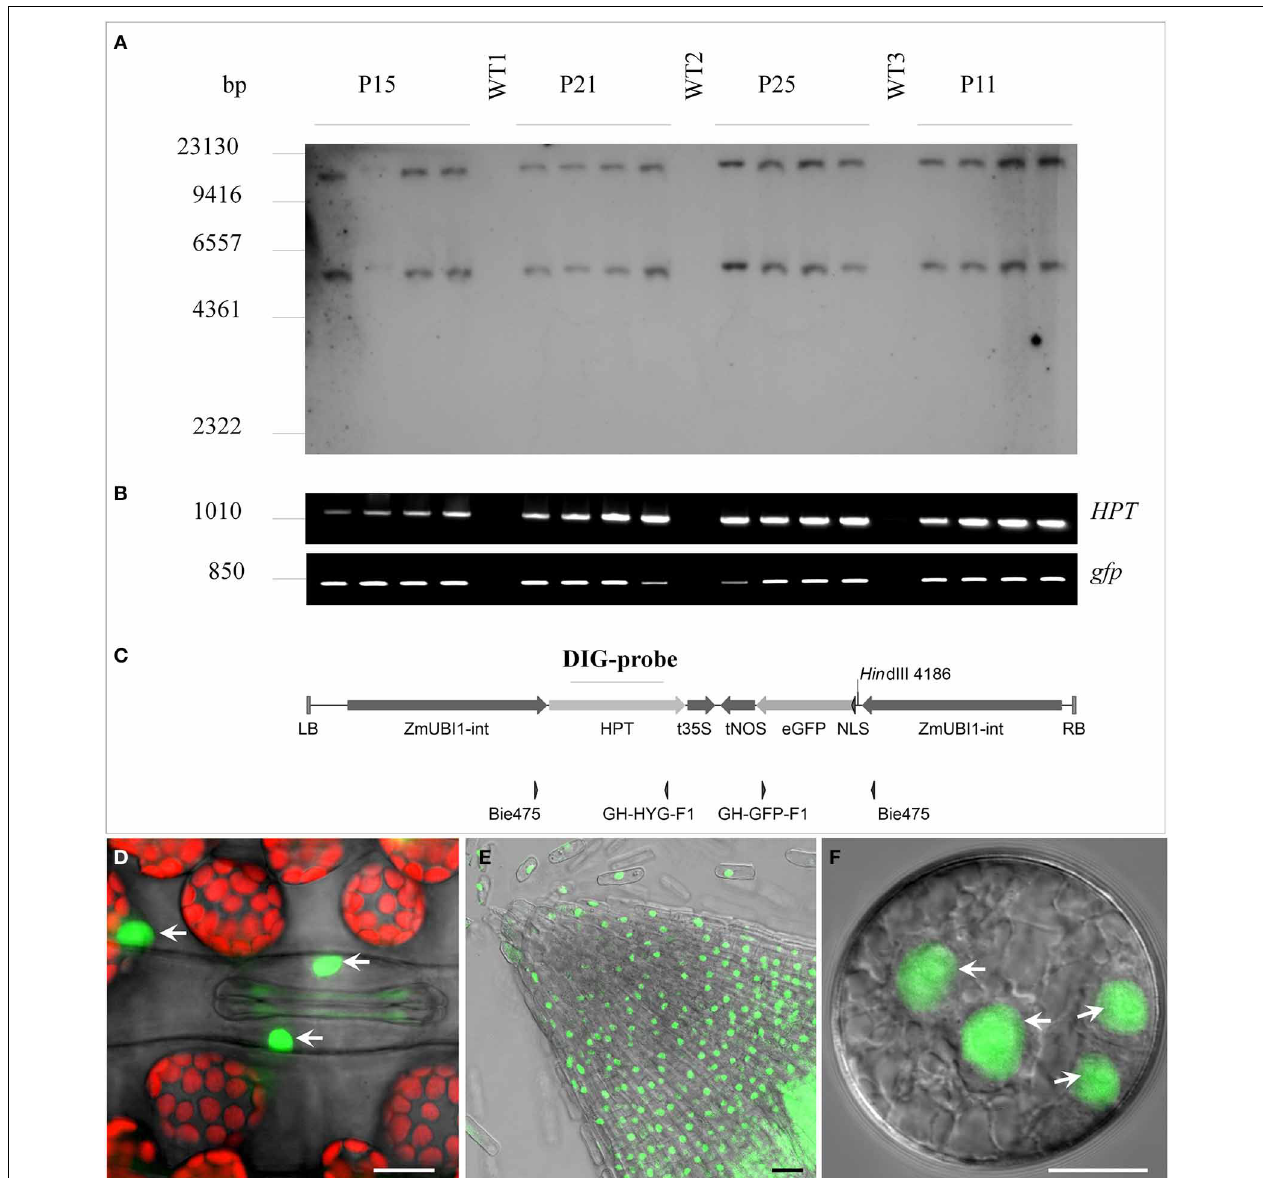
FIGURE 1 | Characterization of the doubled haploid SV40-NLS:GFP transgenic barley line displaying nucleus-specific accumulation of GFP. Randomly chosen T 2 -siblings (four per family) derived from four T 1 -plants (P11, P15, P21, P25) were analyzed for genomic T-DNA integration and transgene zygosity. (A) DNA gel blot analysis of Hin dIII-digested genomic DNA hybridized with an HPT -specific probe. The two bands seen per lane indicate genomic integration of two T-DNA copies. (B) PCR analysis with primer pairs specific for the HPT (upper band) and the GFP (lower band) genes. (C) Map of T-DNA with primer pairs and hybridization probe positions indicated. WT1, 2 and 3,